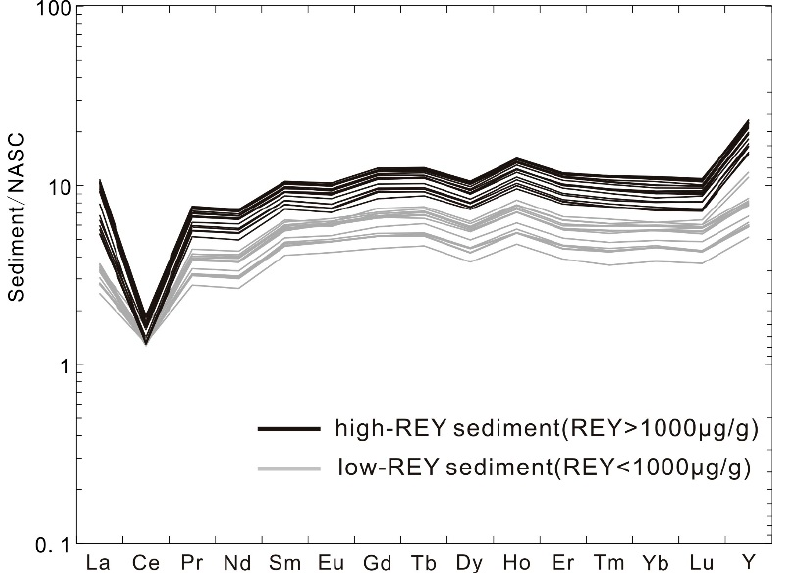
Table 2. Strontium isotopic data for P10 fish teeth debris. Depth (cm) 87 Sr/ 86 Sr (corr)